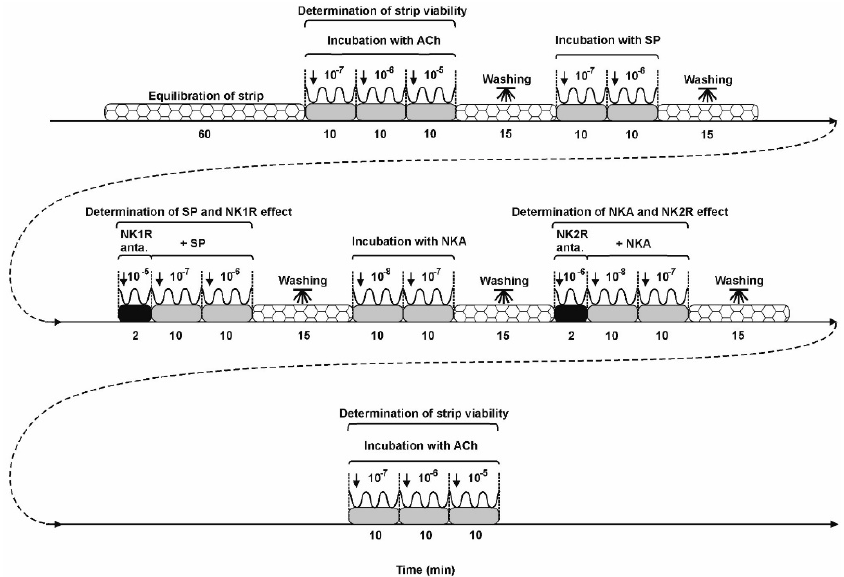
Figure 7. The graphic shows the procedure for measuring contractility of uterine strips. Ach-acetylcholine; SP-substance P; NKA-neurokinin A; NK1R-neurokinin receptor subtype 1; NK2R-neurokinin receptor subtype 2; NK1R anta.-neurokinin receptor subtype 1 antagonist; NK2R anta.-neurokinin receptor subtype 2 antagonist. Concentrations of the used substances are given in moles.